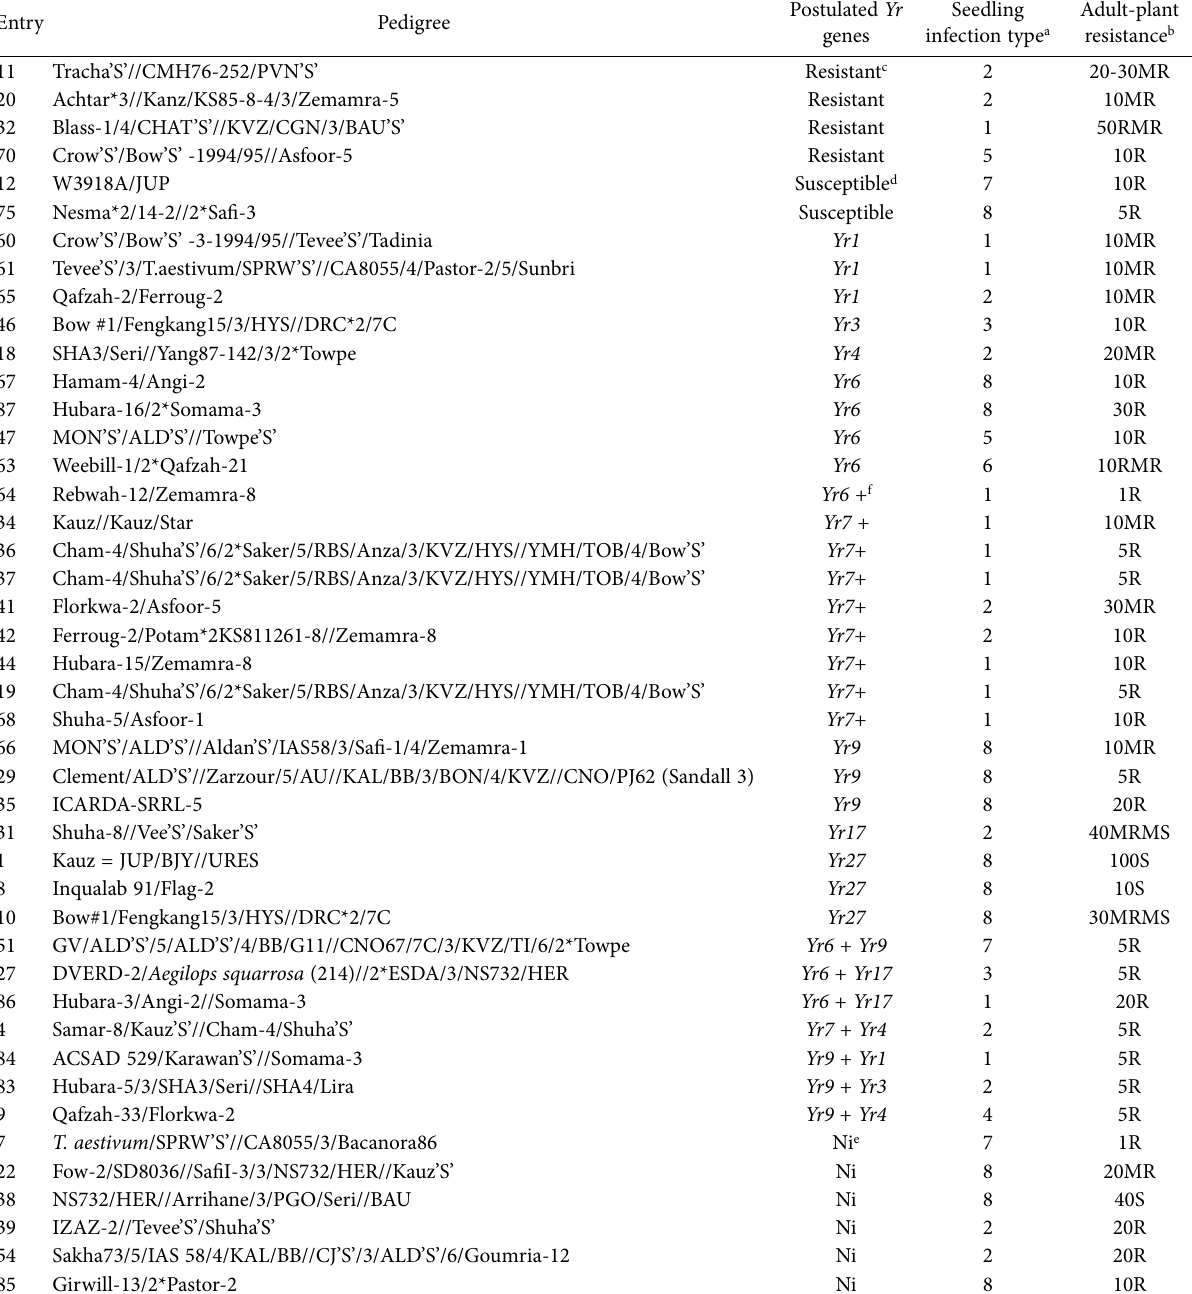
Table 5. Pedigree, postulated seedling-stage stripe rust resistance genes and field responses to stripe rust of 44 advanced bread wheat lines from ICARDA at the Tel Hadya (Syria) and Terbol (Lebanon) research